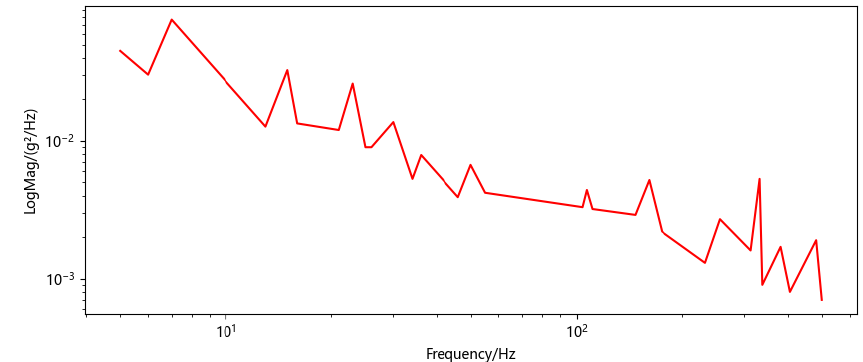
Figure 9. Random vibration power spectrum density.